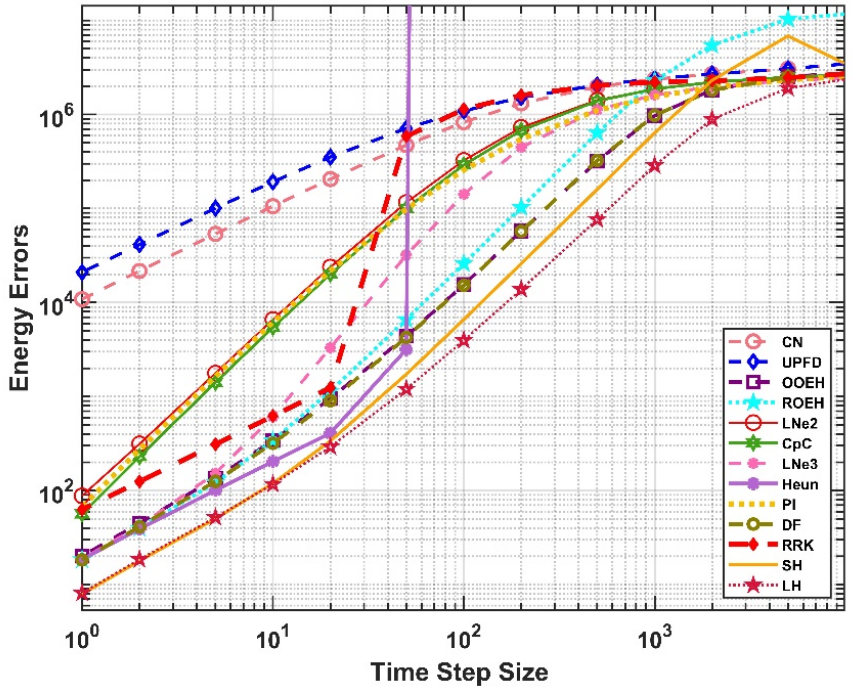
Figure 15. The energy errors defined in (17) as a function of the time step size ∆ t for the non- equidistant mesh.